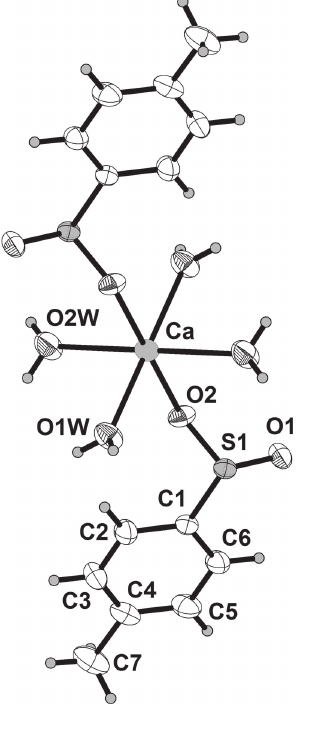
Table 1: Data collection and handling.